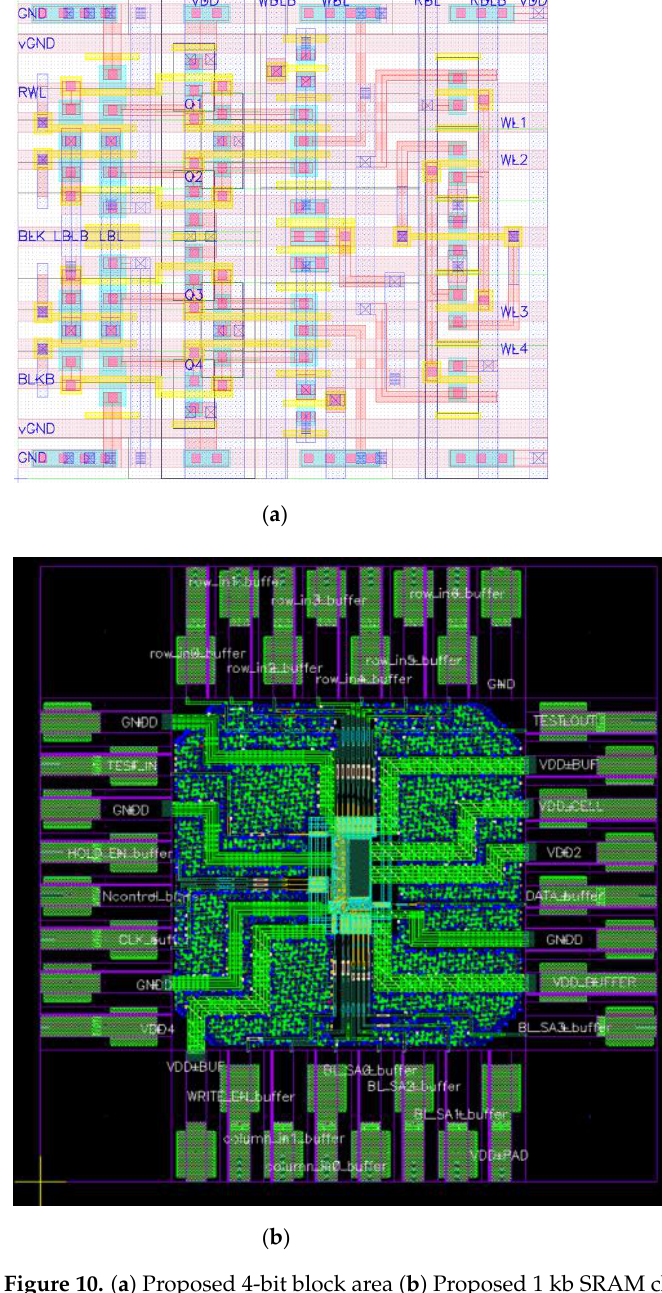
Figure 10. ( a ) Proposed 4-bit block area ( b ) Proposed 1 kb SRAM chip layout.